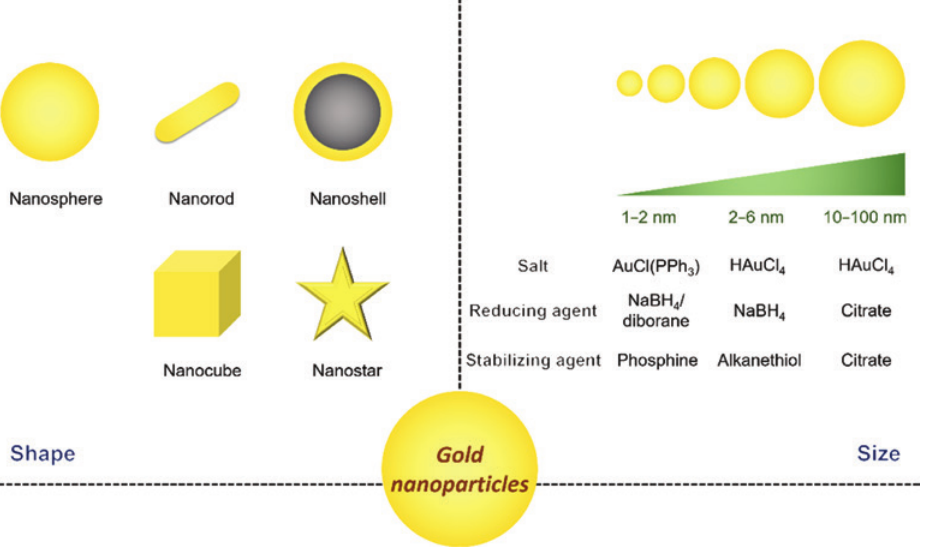
Figure 4: The synthetic versatility of AuNPs. Various shapes and sizes of AuNPs controlled through changing the synthetic